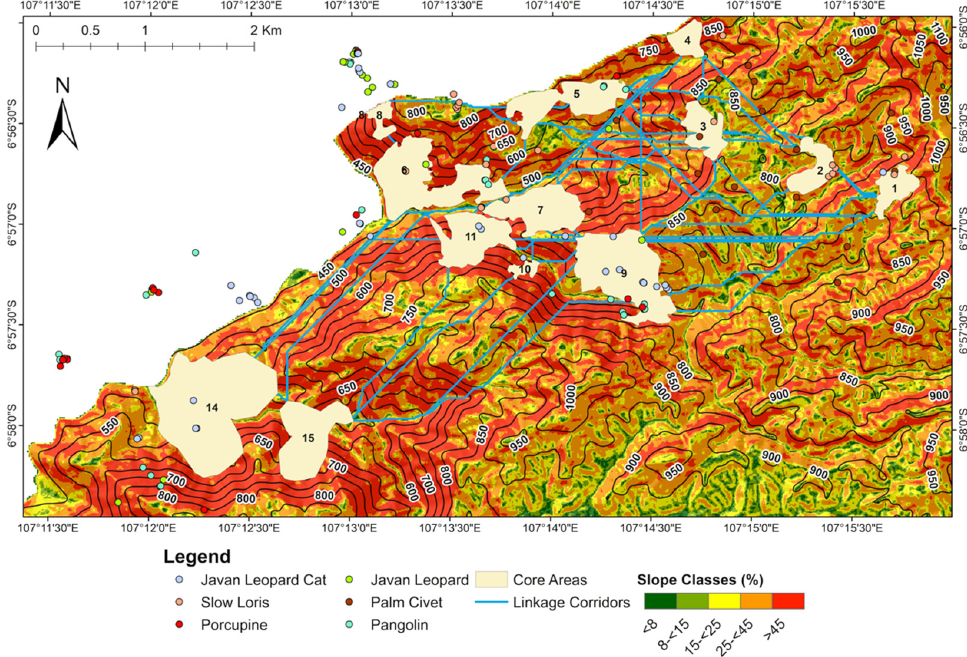
Figure 5. Species distribution and linkage corridors map related to slope gradient.